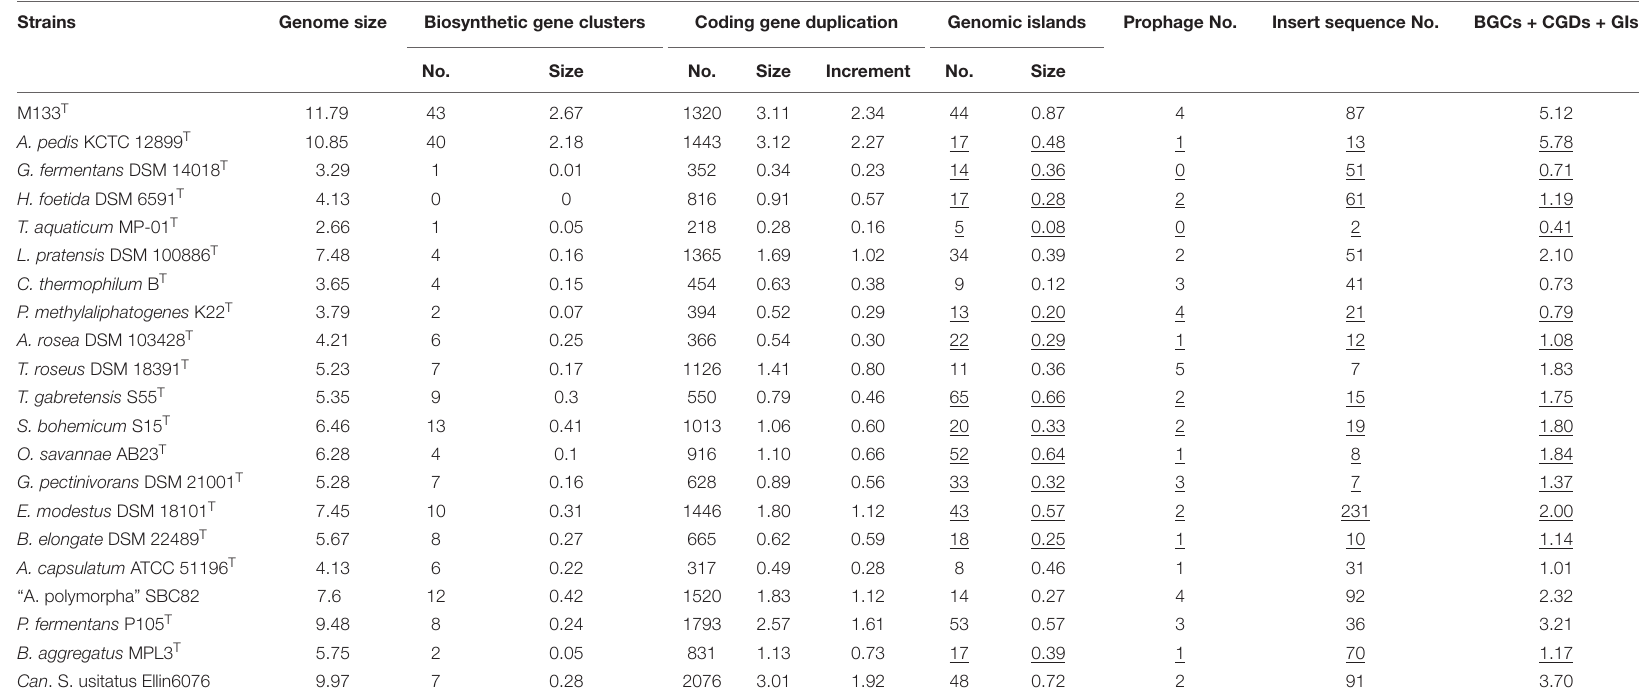
TABLE 1 | Features of selected acidobacterial genomes. Strains Genome size Biosynthetic gene clusters Coding gene duplication Genomic islands Prophage